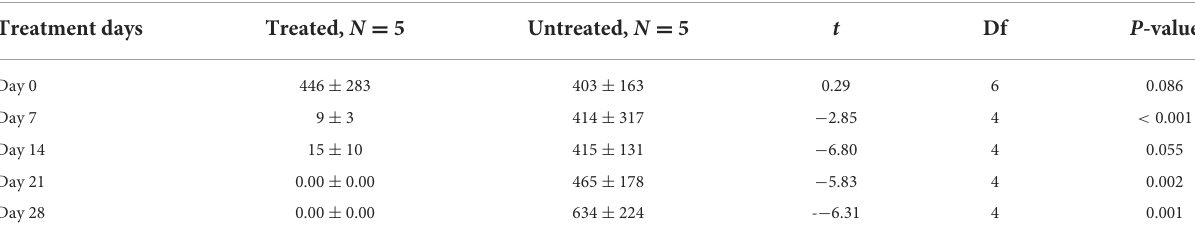
TABLE 5 Effect of diazinon treatment on sheep lice infestation, mean lice count among treated and untreated group in Sayint district, South Wollo, Ethiopia. Mean lice count ± SD